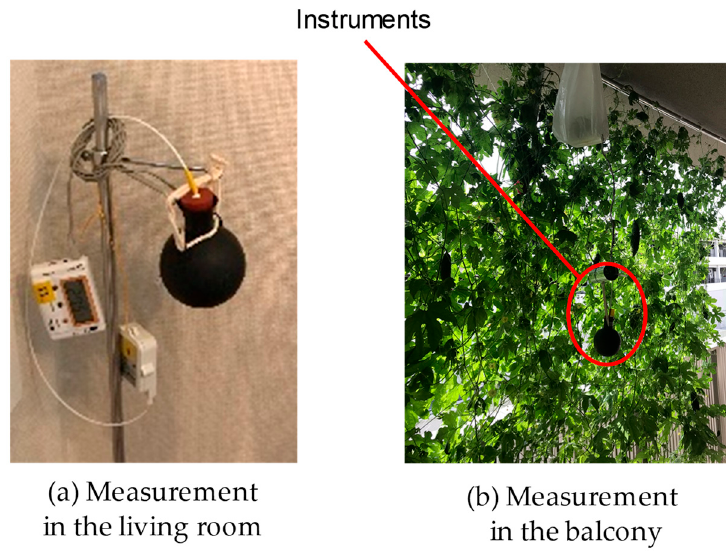
Figure 10. Measurement view of indoor and balcony.